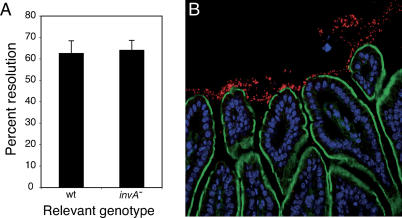

Salmonella Induces Expression of SPI-2 in the Lumen of the Ileum(A) Mouse ileal loops were infected with either wild-type or invA
− PsseA RIVET strains for 15 min before the loops were removed and homogenized, and the percent resolution was determined.(B) Mouse ileal loops were infected with wild-type Salmonella for 15 min before being removed, fixed, stained, and analyzed by confocal microscopy with an oil immersion 40× 1.3 N.A. objective. A representative image is displayed showing host cell nuclei in blue, actin in green, and Salmonella in red.